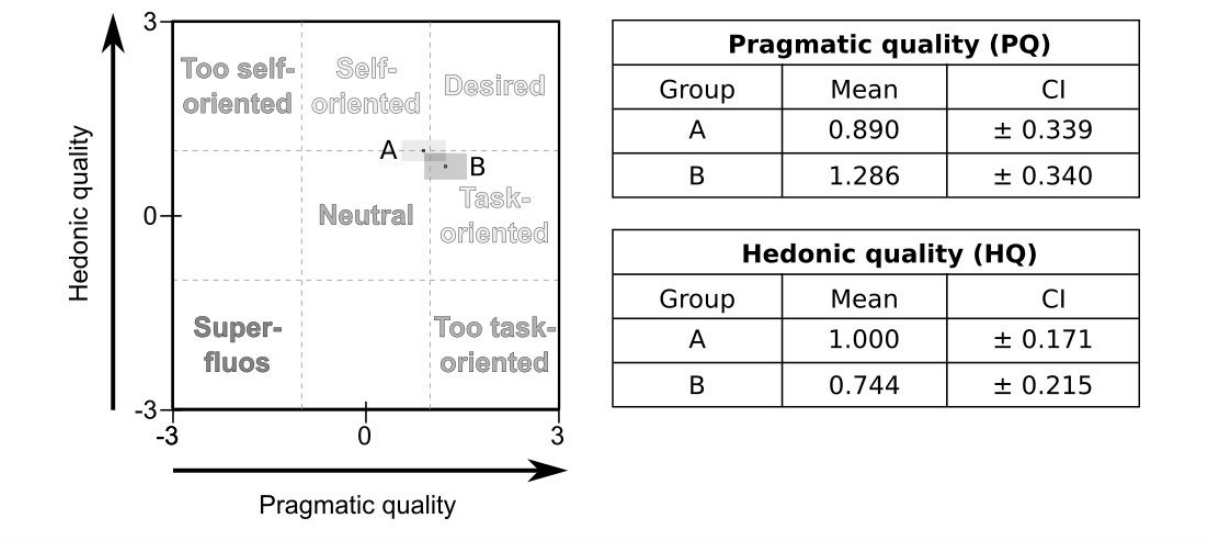
Figure 6. Left: Portfolio with average values of the dimensions pragmatic quality (PQ) and hedonic quality (HQ) and the respective confidence rectangles of A (mobile Augmented Reality blended learning environment [mARble]) and B (mobile blended learning environment [mble]), modified following Hassenzahl et al. Right: Corresponding